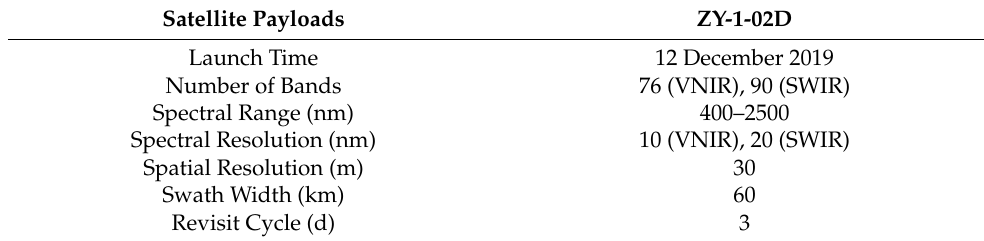
Table 1. ZY1-02D AHSI hyperspectral sensor